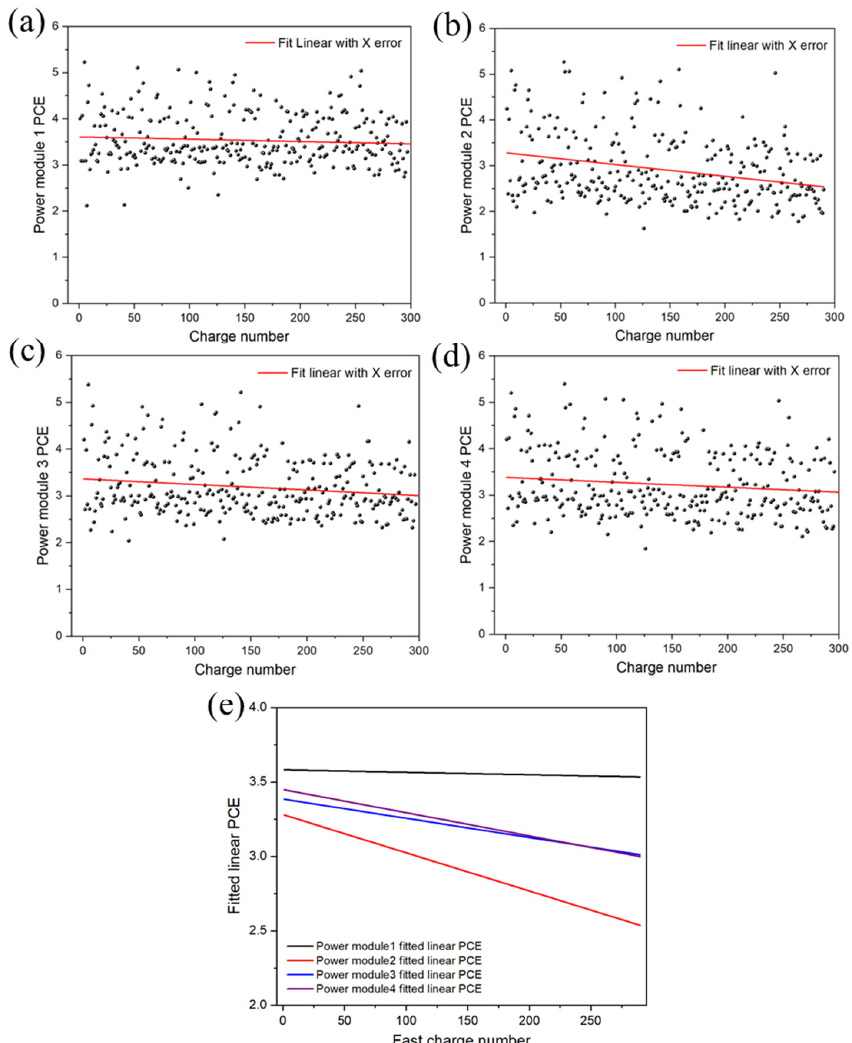
Figure 4. ( a ) No. 1 Power module PCE; ( b ) No. 2 Power module PCE; ( c ) No. 3 Power module PCE ( d ) No. 4 Power module PCE; ( e ) Fitted linear PCE of each power module.